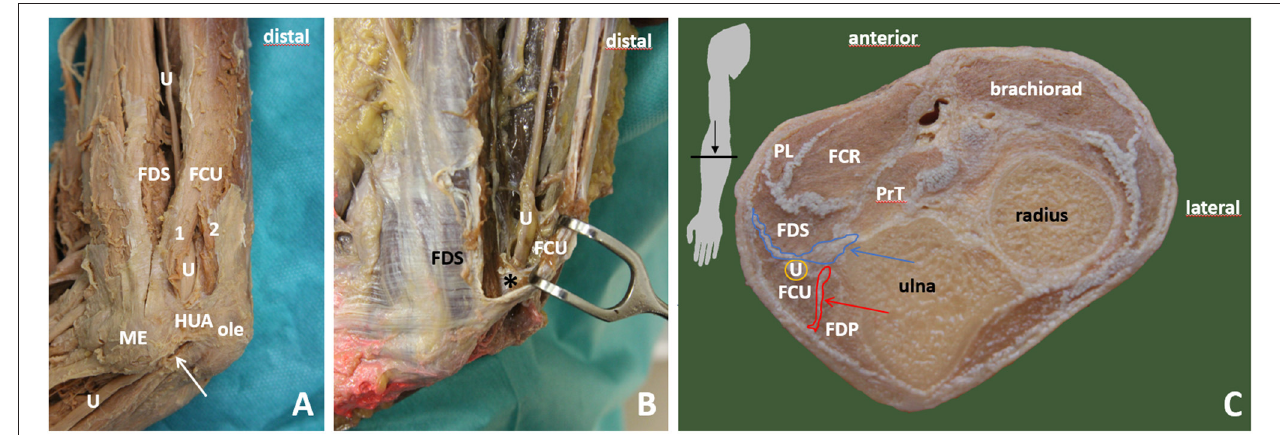
FIGURE 4 | Cubital tunnel. (A) View on proximal part of the cubital tunnel with humeroulnar aponeurotic arcade ( HUA ) and ulnar nerve ( U ) going between humeral (1) and ulnar (2) head of flexor carpi ulnaris muscle ( FCU ). The course of ulnar nerve between FCU and flexor digitorum superficialis muscle ( FDS ). Humeral head is moved away, and the retroepicondylar retinaculum is transsected ( white arrow ). (B) Ulnar nerve exiting the cubital tunnel to forearm. The nerve is in close relationship to intermuscular connective tissue between FCU and FDS ( black asterisk ). (C) Cross section of the forearm depicting the relationship between the ulnar nerve and surrounding muscles and connective tissues ( red and blue arrows ). (1) flexor carpi ulnaris muscle, humeral head; (2) flexor carpi ulnaris muscle, ulnar head; HUA, humeroulnar aponeurotic arcade; Brachiorad, brachioradialis muscle; FCU, flexor carpi ulnaris muscle; FDP, flexor digitorum profundus muscle; FDS, flexor digitorum superficialis muscle; ole, olecranon; PrT, pronator teres; U, ulnar nerve; blue arrow, intermuscular connective tissue between FCU and FDS, deep flexor pronator aponeurosis; red arrow, intermuscular connective tissue between FCU and